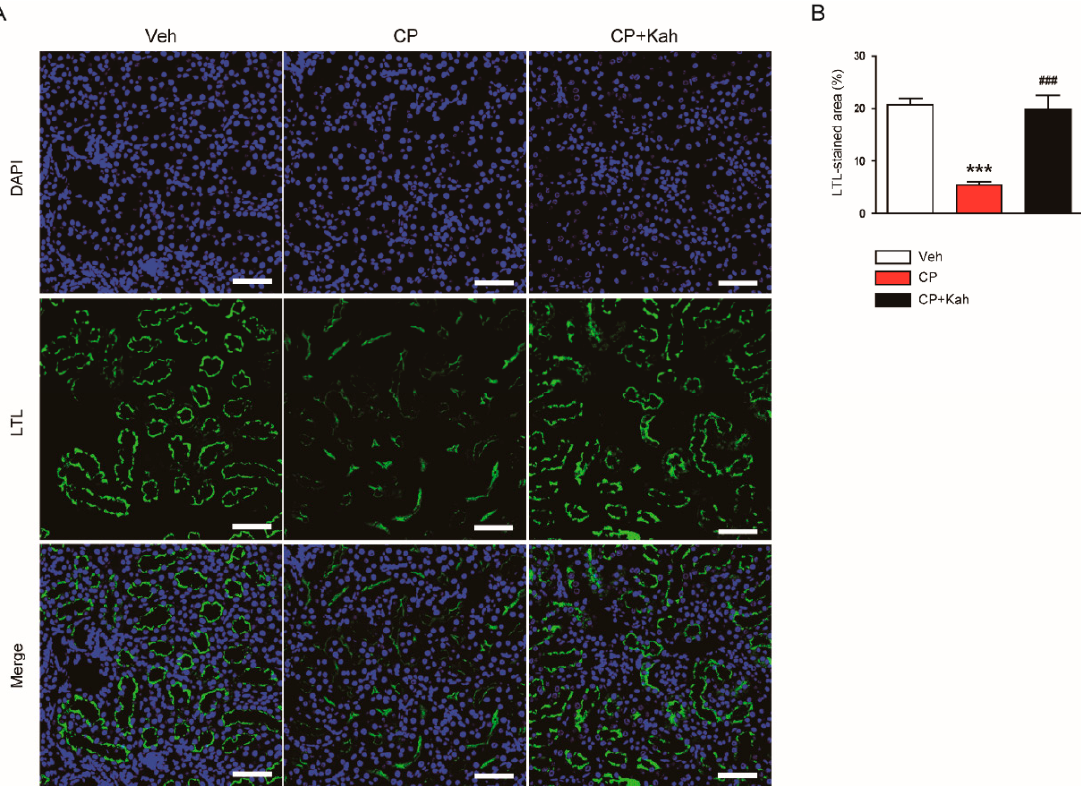
Figure 3. Effect of kahweol on brush border in proximal tubules. ( A ) Lotus tetragonolobus lectin (LTL) staining of kidney tissues. Nuclei were stained with 4 ′ ,6-diamidino-2-phenylindole (DAPI). Scale bar = 50 μ m. ( B ) Percentage of stained areas for LTL. n = 8 per group. *** p < 0.001 vs. Veh. ### p < 0.001 vs. CP.